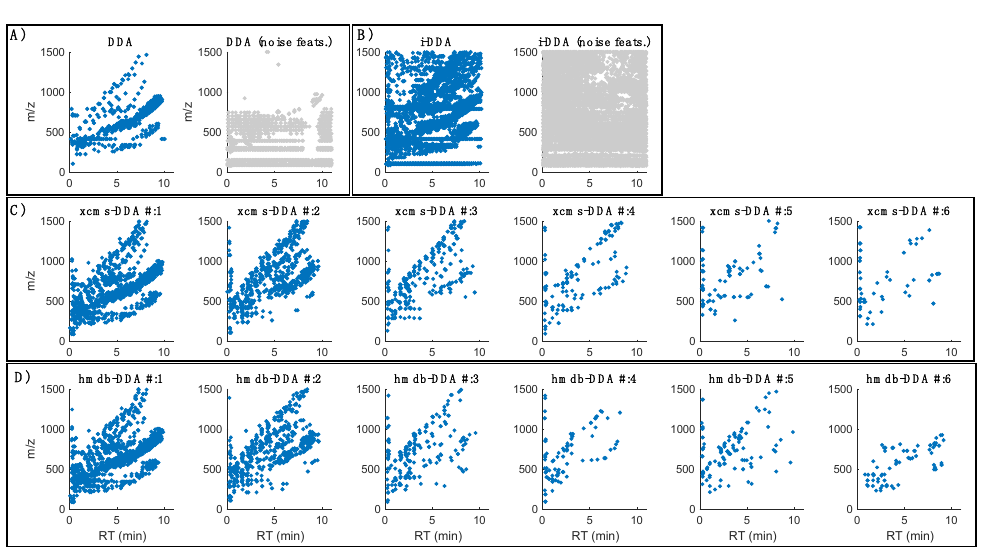
Figure 2. Distribution MS 2 spectra acquired by DDA ( A ), i-DDA ( B ), xcms-DDA ( C ) and hmdb-DDA ( D ) assigned to informative (blue) and noise (grey) LC–MS features. Note: DDA: untargeted selection of precursors in the 70–1500 Da range; i-DDA: untargeted iterated DDA, in which MS 2 spectra were acquired in seven QC replicates using DDA in the [70-200], [200-400], [400-600], [600-800], [800-1000], [1000-1250], and [1250-1500] Da ranges; xcms-DDA: targeted dynamic iterated DDA, in which precursor ions were selected using an inclusion list generated from the cleaned-up peak table obtained after the injection of two blanks and three QCs during system conditioning; hmdb-DDA: targeted dynamic iterated DDA using an inclusion list of (pre)annotated features in the cleaned-up peak table obtained after the injection of two blanks and three QCs during system conditioning.